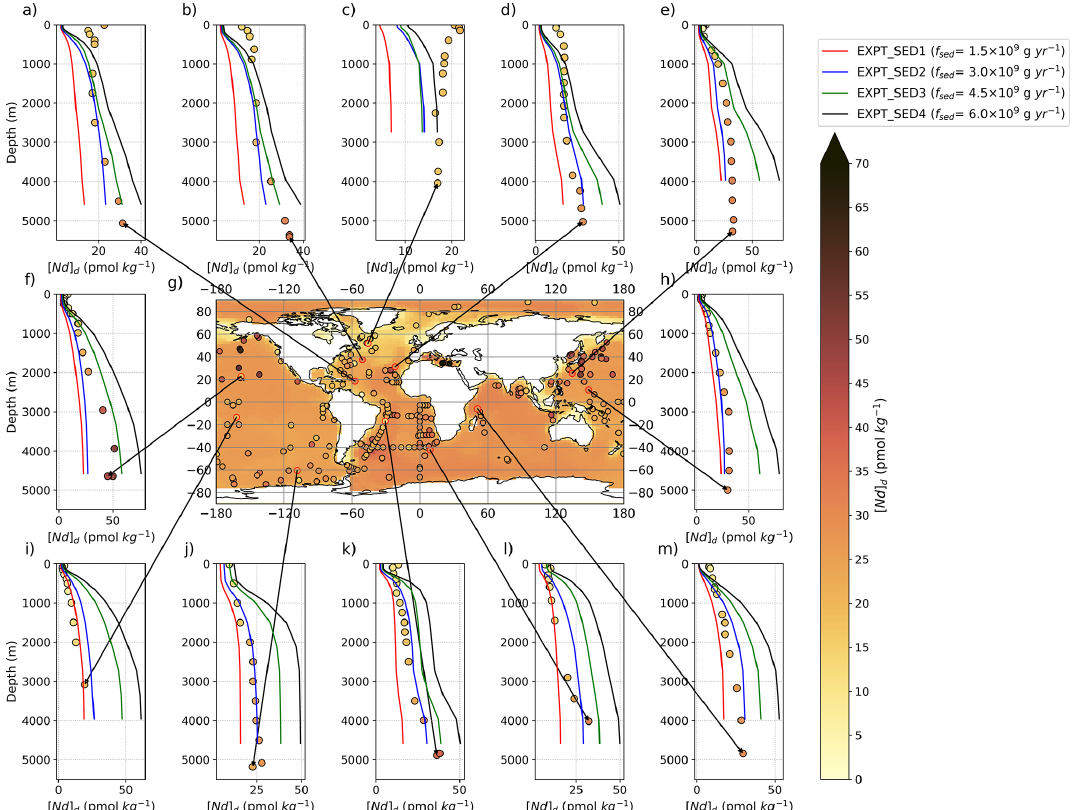
Figure 15. The central panel (g) displays [Nd] d at the seafloor (i.e. lowermost box of the ocean model) in simulation EXPT_SED2 (100-year mean from the end of the run), with superimposed water column measurements (Osborne et al., 2017, 2015; GEOTRACES Intermediate Data Product Group, 2021) from ≥ 3000m shown by filled coloured circles on the same colour scale. The surrounding panels (a) – (f) and (h) – (m) display depth profiles of simulated (coloured lines, one per sensitivity simulation with varied f sed ) and measured (filled circles) [Nd] d , respectively. Larger shifts in the [Nd] d between simulations highlight the regions most sensitive to the magnitude of the seafloor sediment